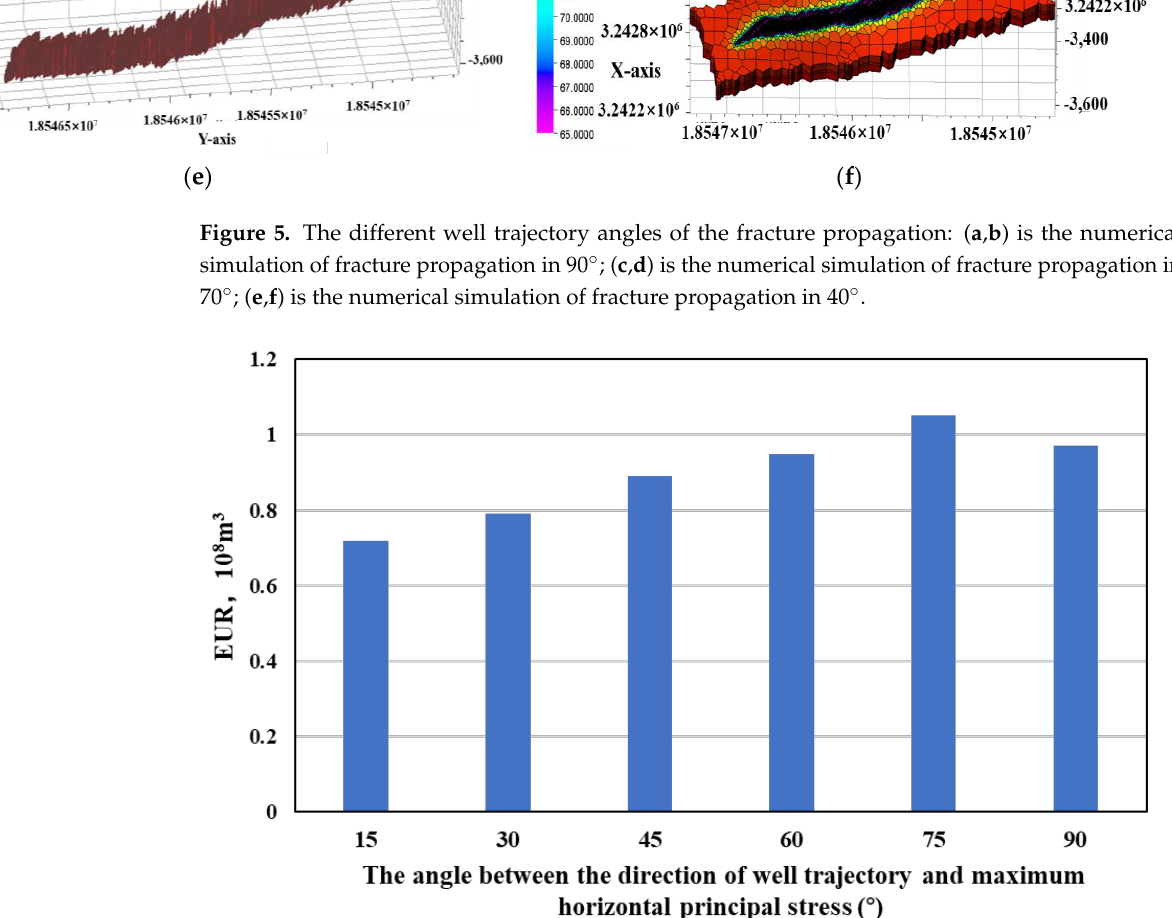
Figure 6. The EUR of different angle.